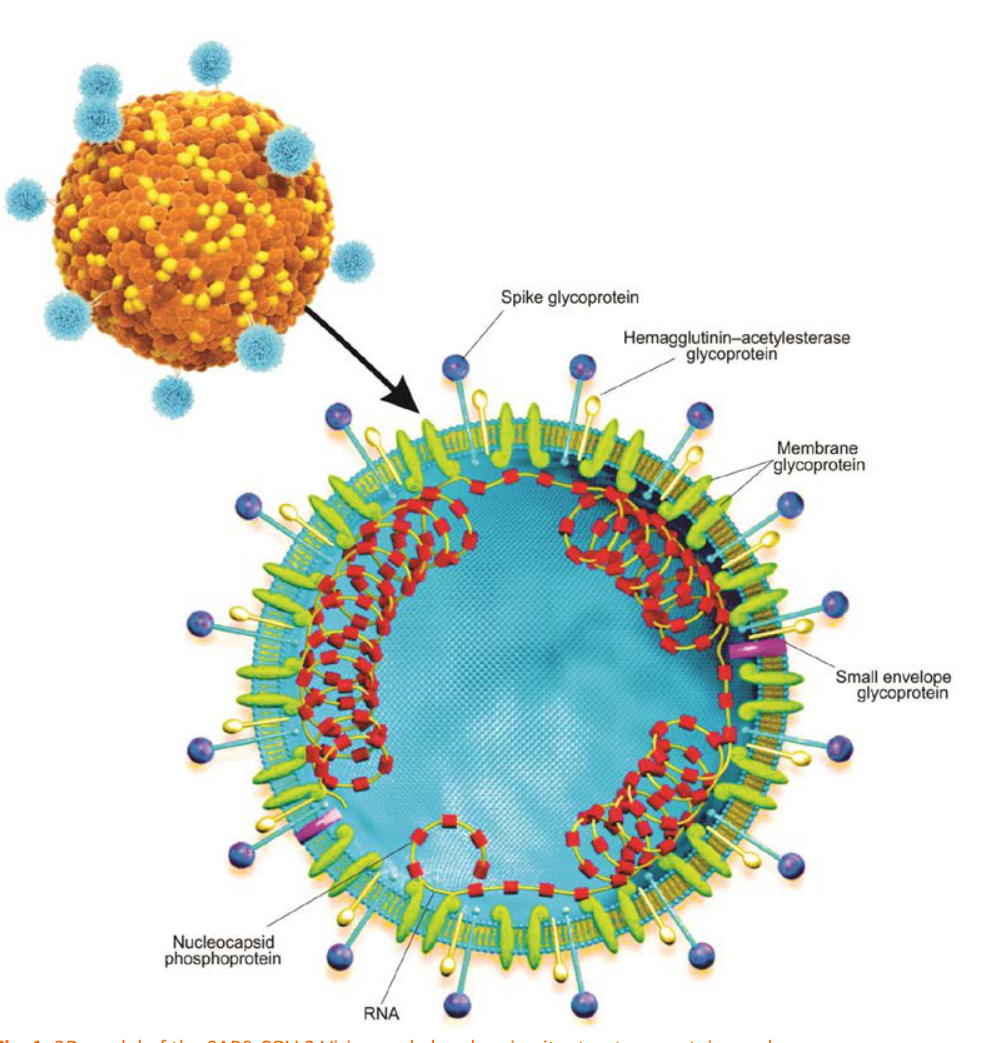
Fig. 1. 3D model of the SARS-COV-2 Virion and also showing its structure proteins and genome Image modified from source